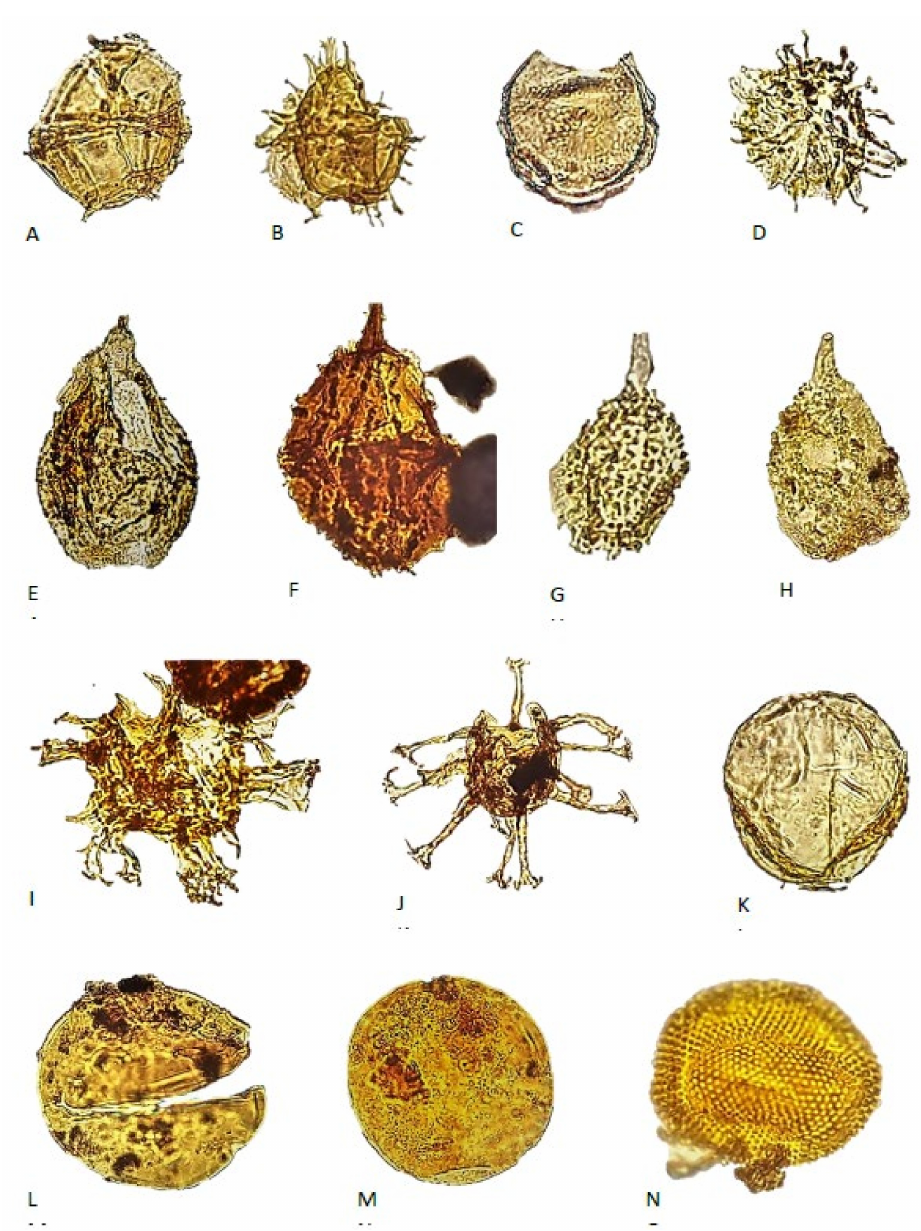
Figure 8. Marine palynomorphs from boreholes Bh 1, Bh 2 and Bh 3. ( A ) Gonyaulacysta helicoidea , Bh 3, 89.7 m (6), width 54 µ m. ( B ) Spiniferites sp., Bh 2, 72.6 m (7), width 57 µ m. ( C ) Ambonosphaera? staffinensis , Bh 1, 22.23 m (7), width 56 µ m. ( D ) Kiokansium polypes , Bh 2, 89.7 m (6), width central body 46 µ m. ( E ) Cribroperidinium globatum , Bh 3, 80.81 m (5), width 60 µ m. ( F ) Cribroperidinium edwardsi , Bh 2, 68.35 m (4), width 66 µ m. ( G ) Chlamydophorella trabeculosa , Bh 2, 25.0 m (5), width 61 µ m. ( H ) Pareodinia sp. 1, Bh 2, 196.95 m (4), width 63 µ m. ( I ) Perisseiasphaeridium pannosum , Bh 1, 65.35 m (5), width central body 54 µ m. ( J ) Oligosphaeridium complex , Bh 2, 68.35 m (4), width central body 43 µ m. ( K ) Cribroperidinium? sp, Bh 2, 89.7 m (7), width 78 µ m. ( L ) Tasmanites sp., Bh 3, 16.6 m (5), width 98 µ m. ( M ) Tasmanites sp., Bh 4, 25.15 m (3), width 92 µ m. ( N ) Tasmanitid indet., Bh 3, 16.5 m (5), width 103 µ